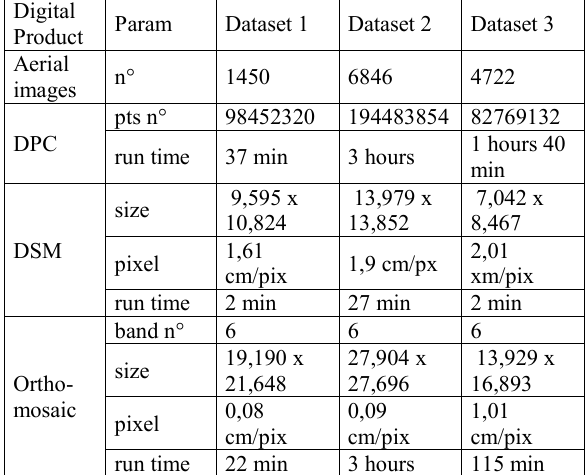
Table 6. Summary of processing parameters and accuracy results of the Judean foothills site's digital products.